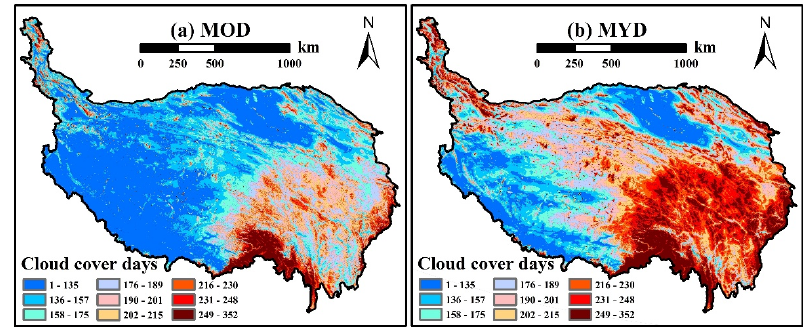
Figure 8. Cloud-gap duration maps across the TP, with average values from 2003 to 2018: ( a ) MOD10A1 and ( b ) MYD10A1. Clouds (250), missing data (200), and no decision (201) were all regarded as clouds in this